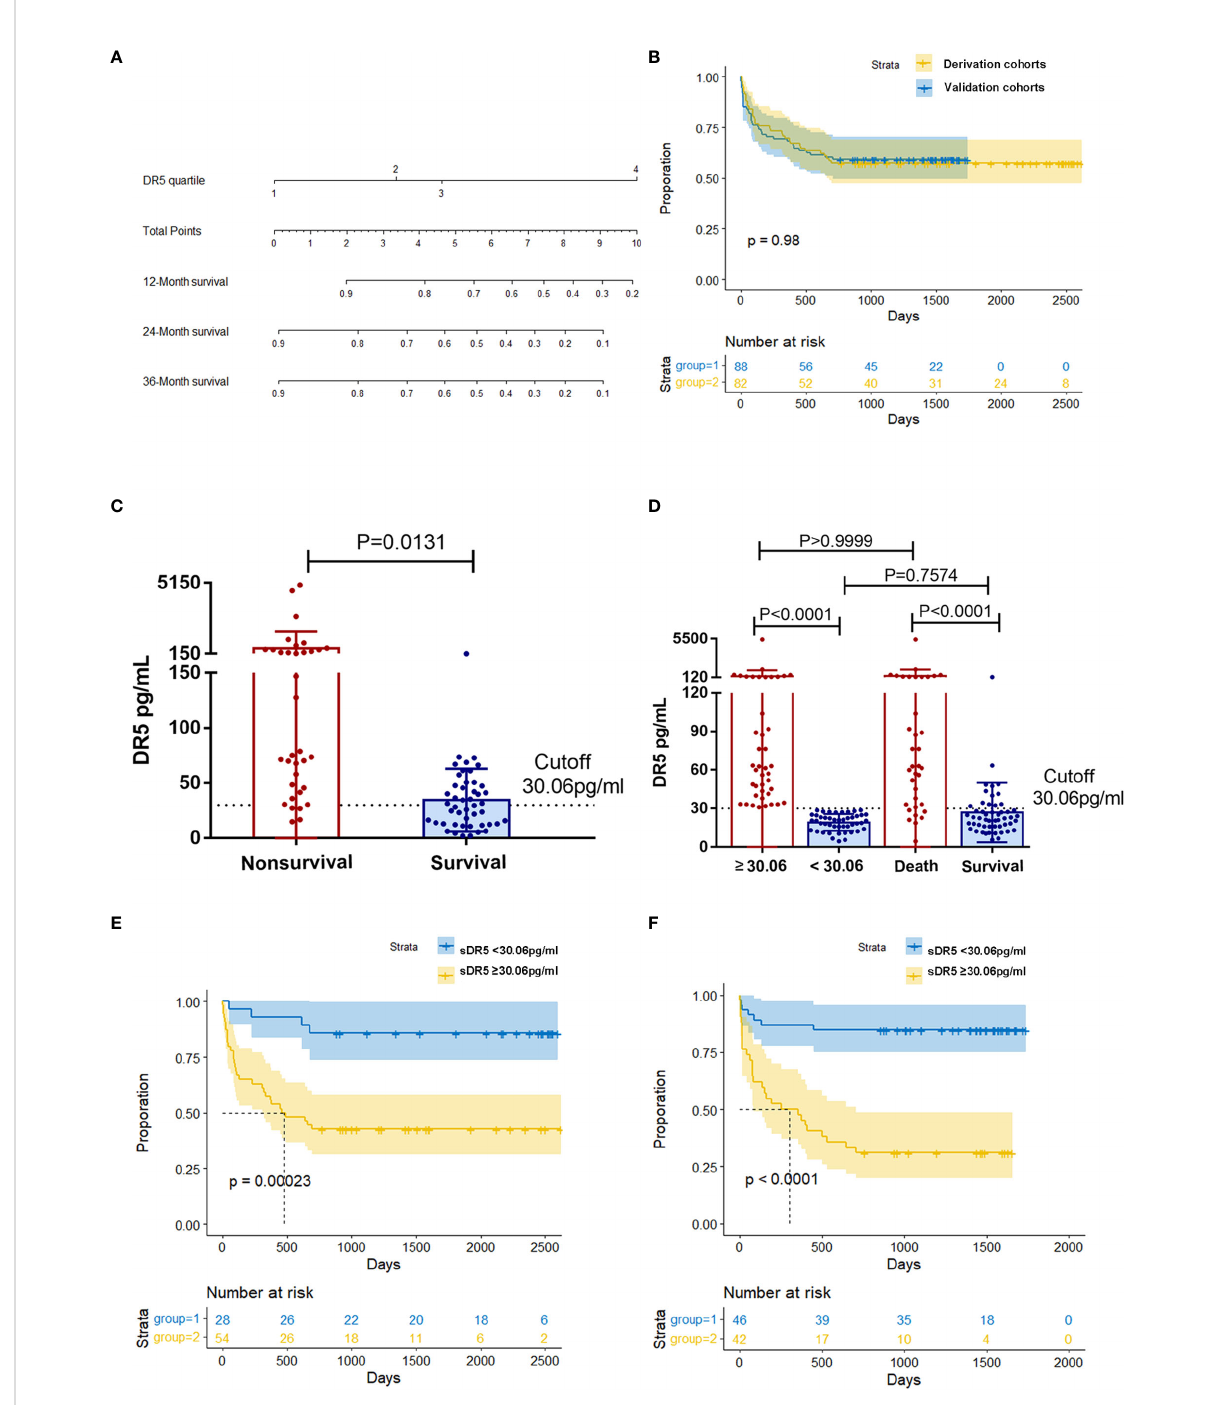
FIGURE 3 Relationship between different expression levels of sDR5 and 2-year prognosis in patients with HCC. (A) Nomogram of sDR5 predicting 1-, 2-, and 3-year overall survivals of patients with HCC. (B) Kaplan – Meier estimates of overall survival in the derivation and validation samples. Comparison of sDR5 expression levels between survival and non-survival groups within 2 years in derivation (C) and validation cohort (D) . Difference in sDR5 expression between high/low expression group and survival/non-survival group were compared in the validation cohort (D) . Kaplan – Meier estimates of overall survival between high/low expression group in the derivation (E) and validation (F) cohort when using cutoff value